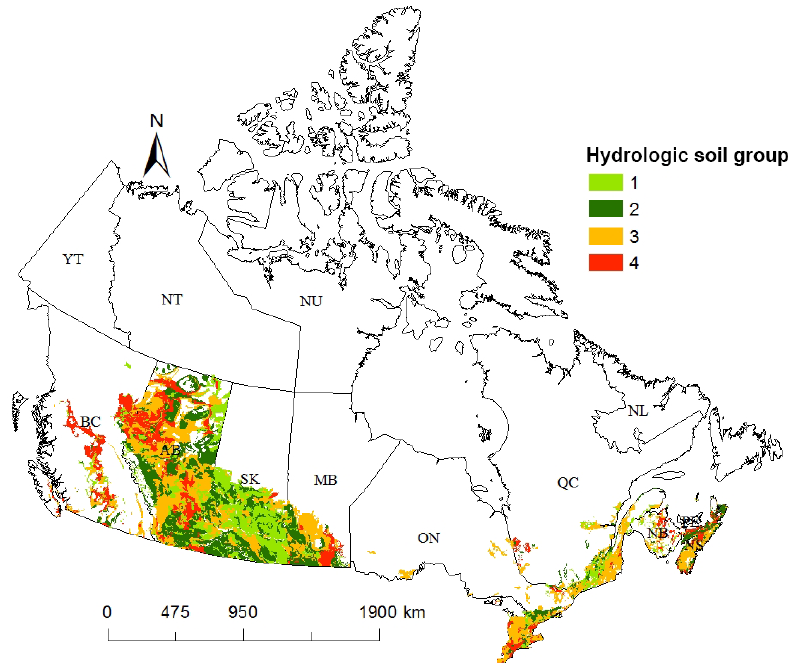
Figure 2. Spatial distribution of the hydrologic soil groups (HYDGRP) variable calculated for the Soil Landscapes of Canada (SLC) database. HSG A = 1, HSG B = 2, HSG C = 3, and HSG D = 4 shown for the provinces of Prince Edward Island (PE), Nova Scotia (NS), New Brunswick (NB), Quebec (QC), Ontario (ON), Manitoba (MB), Saskatchewan (SK), Alberta (AB), and British Columbia (BC). Some HSGs could not be mapped (e.g., province of Newfoundland and Labrador (NL)) due to missing records in the PAT of the GIS layer or being part of the soils with missing data in the